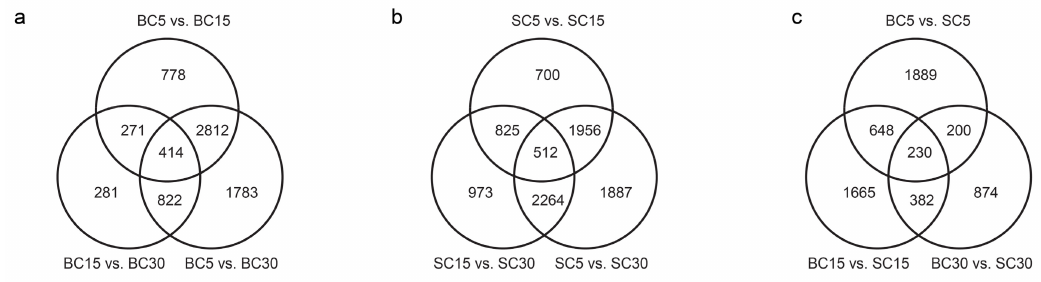
Figure 3. Overview of the serial analysis of differentially expressed genes (DEGs) identified by pairwise comparisons of the six transcriptomes: SC5, SC15, SC30, BC5, BC15, and BC30. ( a ) Venn diagram of the DEGs in bent culm (BC) at the three stages; ( b ) Venn diagram of the DEGs in straight culm (SC) at the three stages; ( c ) Venn diagram of the DEGs between BC and SC at the three